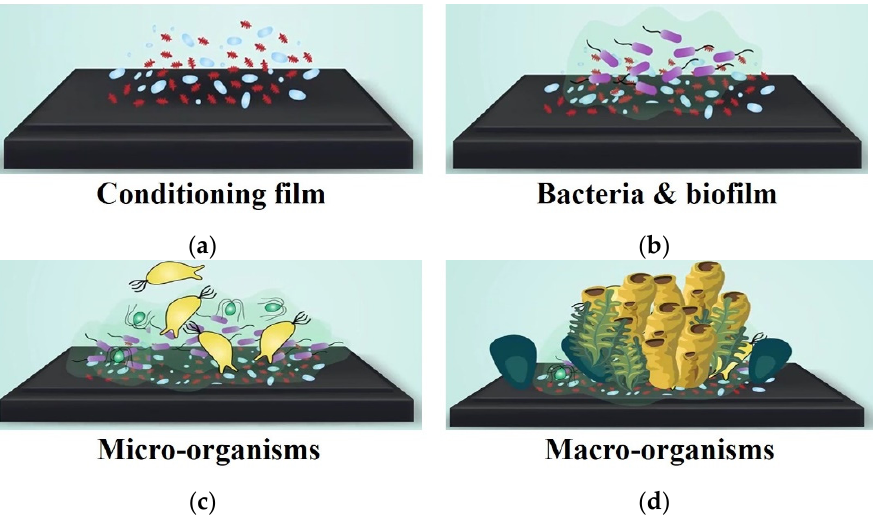
Figure 1. Biofilm formation involves four main stages of colonization. ( a ) The initial attachment of protein generates biofilm on the material surface; ( b ) bacteria and other bio − substances are attached to the biofilm; ( c ) bio − substances are continuously accumulated to create colonization of micro − or- ganisms; ( d ) accumulation of macro − organisms.